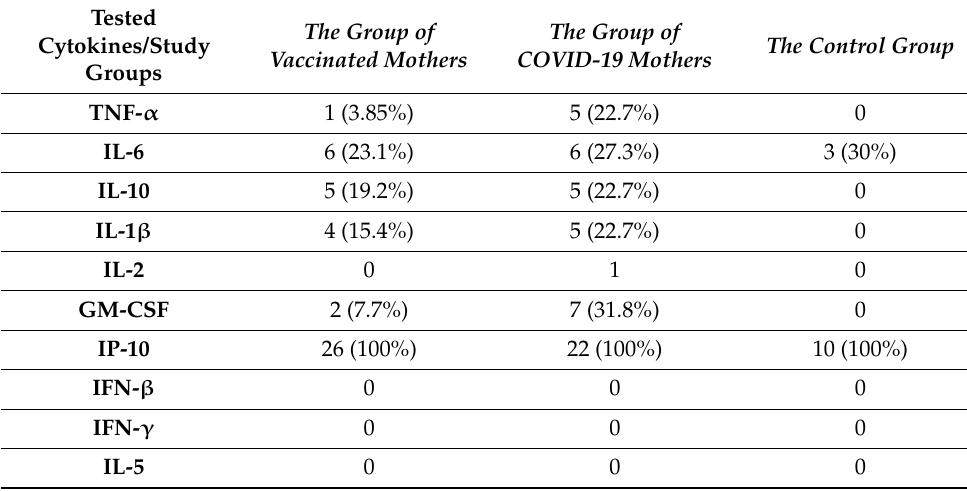
Table 3. The number (and percentage) of mothers with elevated concentrations of cytokines corre- sponding to each study group.